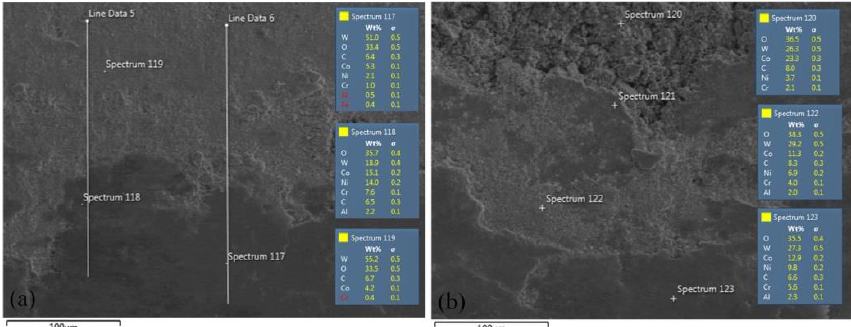
Figure 8. Surface micrographs with EDS point analysis of worn surfaces at 500 °C under 2 N load: ( a ) D-gun coating technique; ( b ) SSPS coating technique.